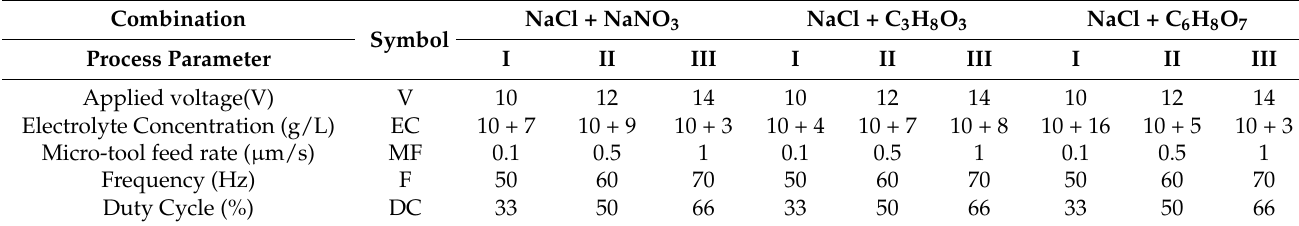
Table 1. Selection of process variables with their levels.